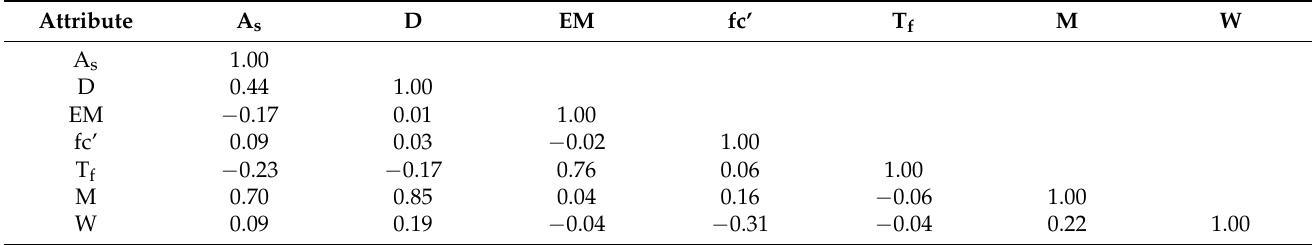
Table 3. Correlation matrix among variables used in the development of